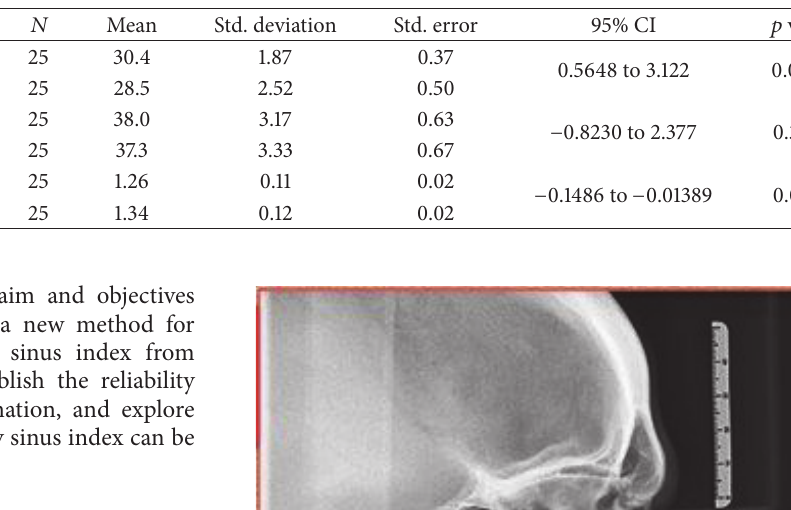
Table 1: Comparison between maxillary sinus height, width, and MSI in males and females.